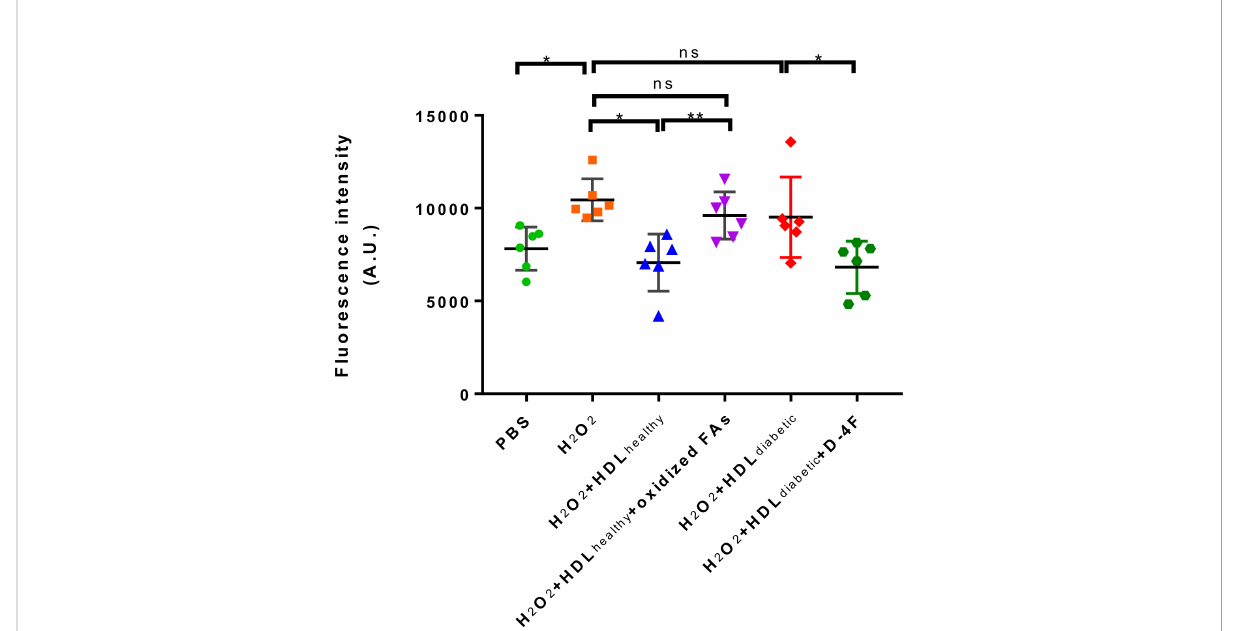
FIGURE 5 The effects of oxidized fatty acids and D-4F on the antioxidant functions of HDLs. HAECs were pre-incubated with 10 uM DCFH-DA for 20 min, then treated with PBS, 500 uM H 2 O 2 , H 2 O 2 plus 500 ug/mL HDL from healthy controls (n=6), H 2 O 2 plus 500 ug/mL HDL from healthy controls (n=6), and a mixture of oxidized fatty acids (FAs) composed of 20 ng/mL PGD2, 9-HODE, 8-HETE, and 5(6)-EET, H 2 O 2 plus 500 ug/mL HDL from diabetic subjects (n=6) and 50 ug/mL D-4F for 30 min, respectively. The intracellular fl uorescence intensity produced by DCF was determined. ** p < 0.01, * p < 0.05, ns: not signi fi cant. p values were obtained from analysis of paired Student ’ s t